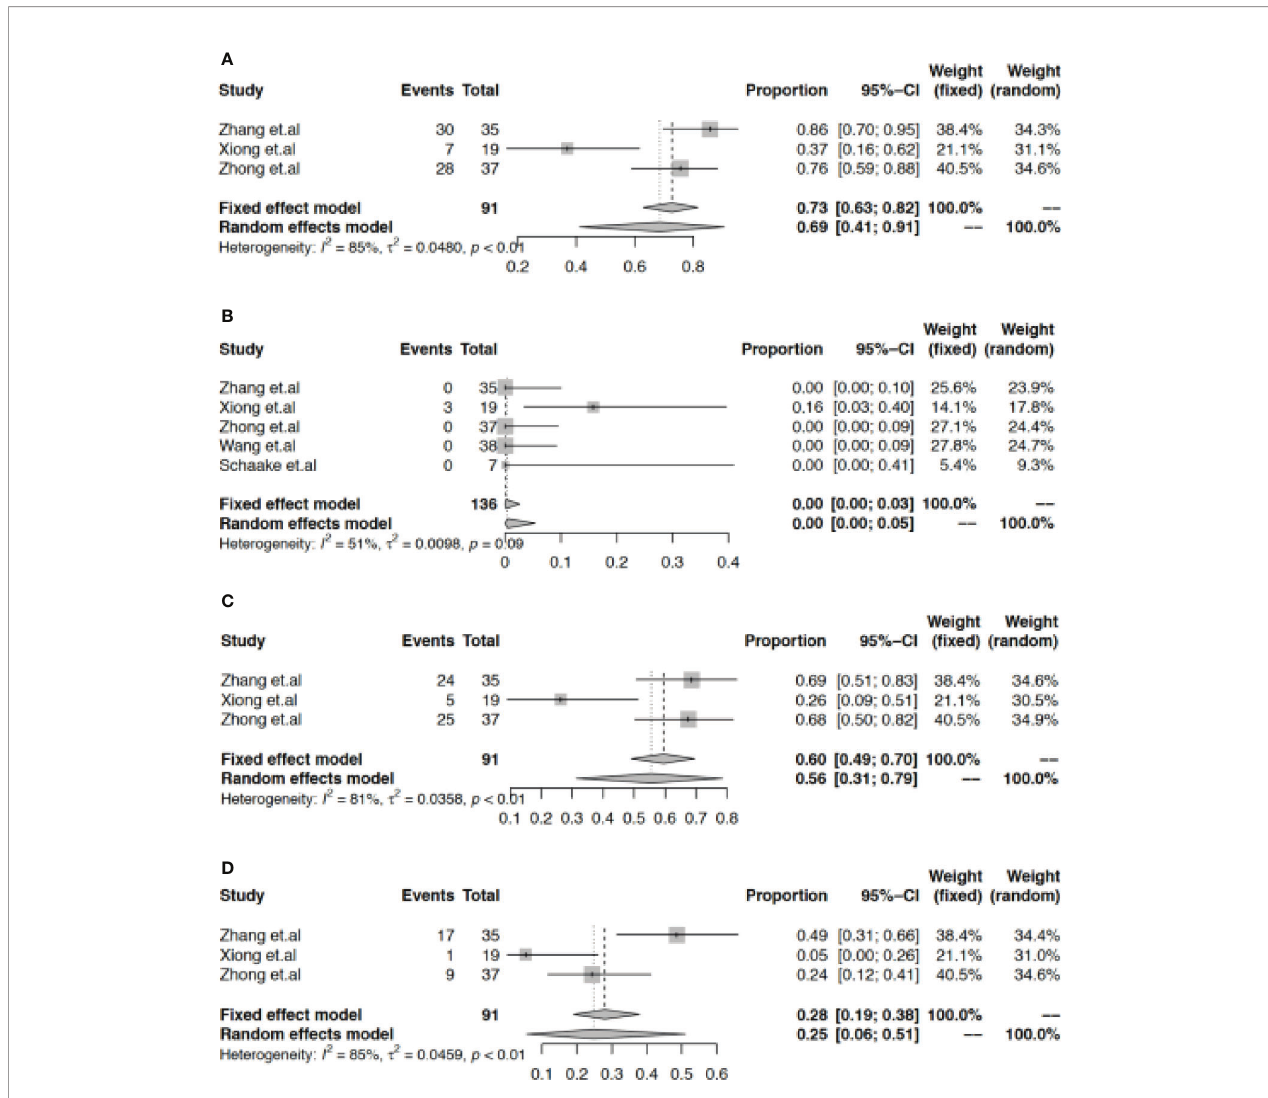
FIGURE 3 | Meta-analysis of the rate of adverse effects. The pooled rate of grade 1-2 AEs (A) , grade 3-4 AEs (B) , rash (C) , and diarrhea (D)